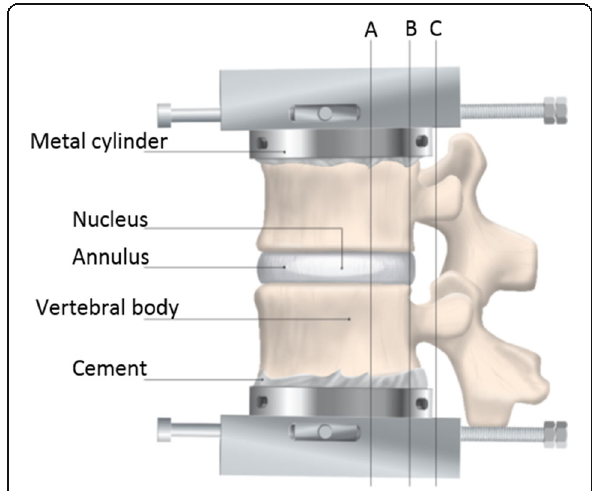
Fig. 2 Sagittal location of pivot point according to flexion ( a ) and extension ( c ) in relation to the most dorsal point of vertebrae ( b